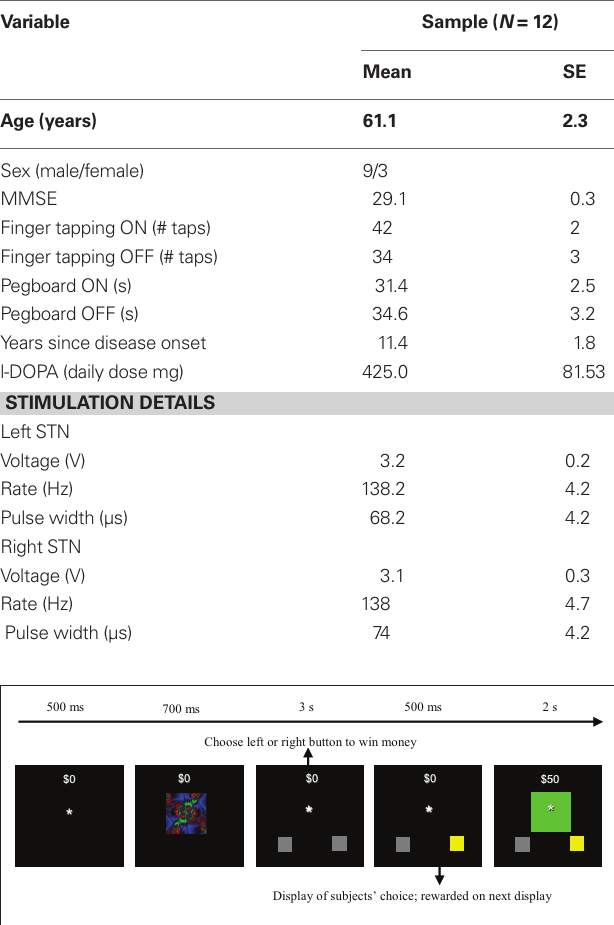
Figure 1 | Trial example of the probabilistic learning task adapted from Haruno and Kawato (2006a,b). In the example, the subject receives a reward by pressing the right button with this specific